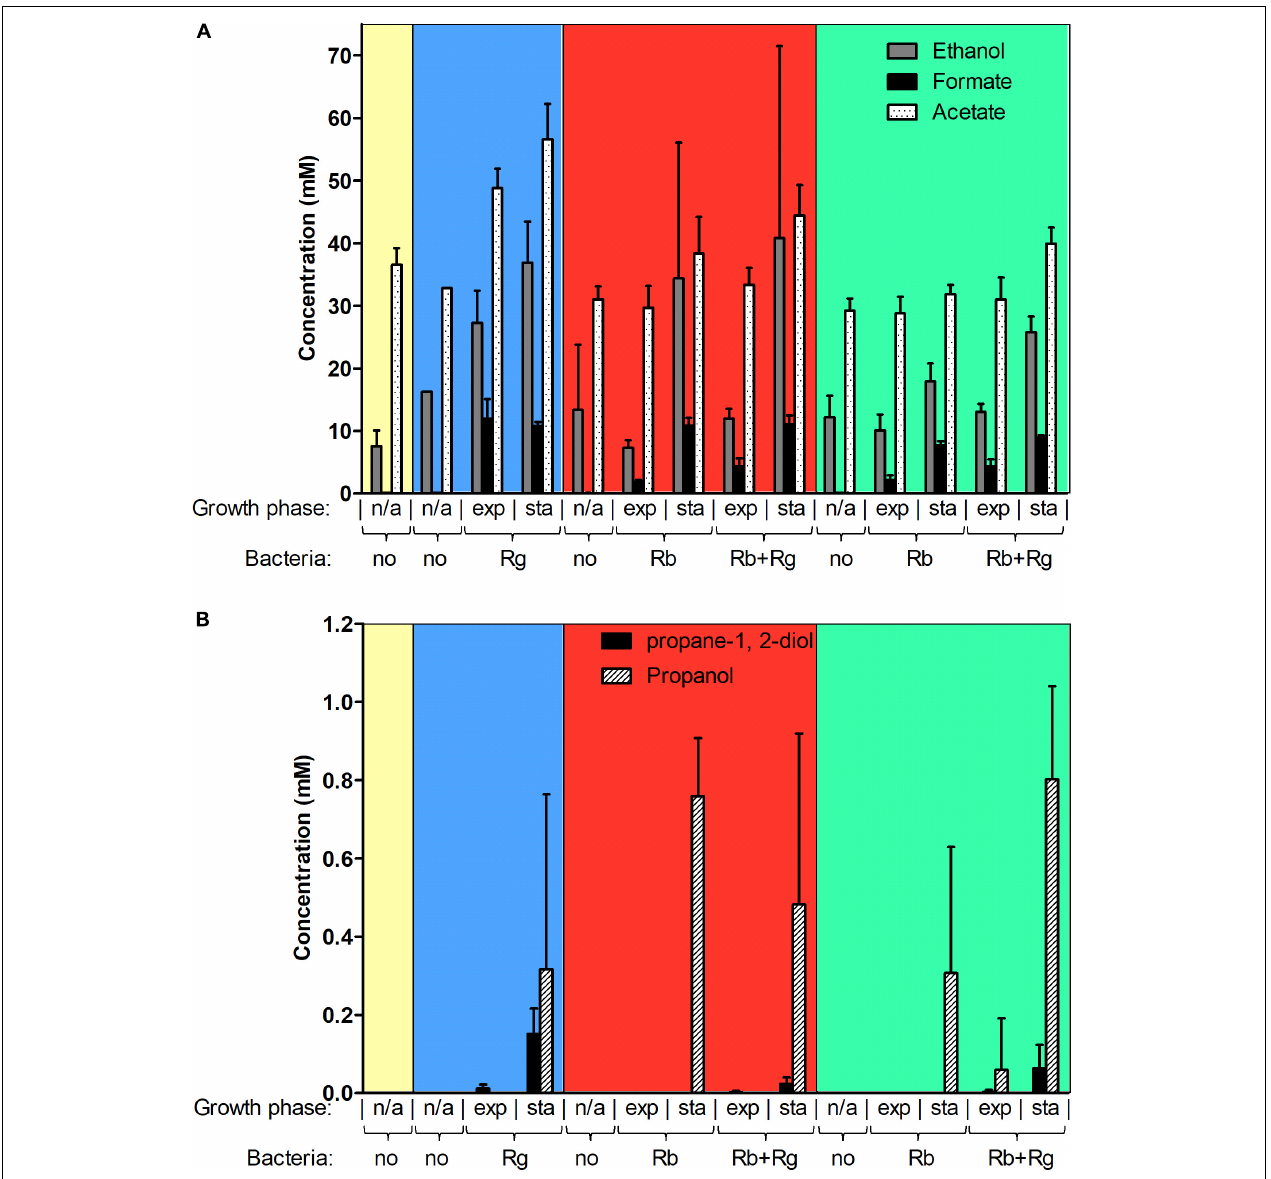
FIGURE 3 | Concentration of different metabolites in the spent media. Concentrations of ethanol, formate and acetate are shown in panel (A) while concentrations of propane-1, 2-diol and propanol are shown in panel (B) . These concentrations were determined by 1 H NMR and the values are averages of 2 to 5 replicates. The error bars correspond to standard deviations. Results presented in the blue, red and green boxes correspond to growth assays with Glc, SS and RS as sole carbon source, respectively. Results from the YCFA medium alone, without carbon source, are presented inside the yellow box. Abbreviations: exp, exponential; sta, stationary; n/a,